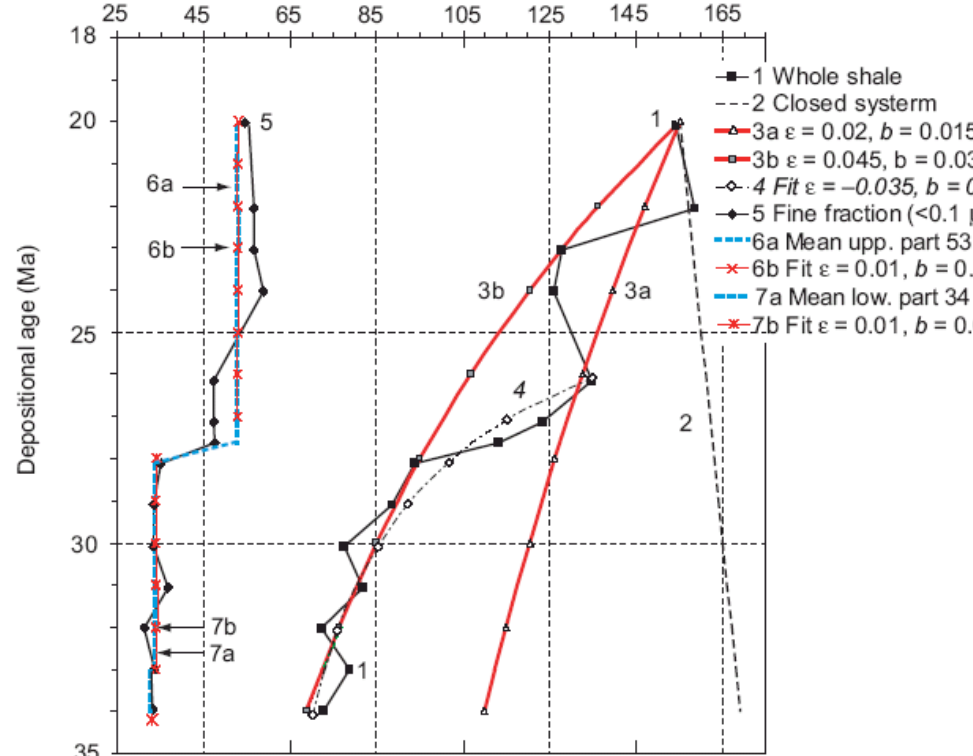
Figure 8. The K-Ar apparent ages of the coarse- (line 1) and fine-grained size fractions (line 5) of the Gulf Coast sequence [37]. For the coarse-grained fraction: calculated K-Ar dates if the particles were a closed system (line 2); data points approximately bracketed by the two-process model of 40 Ar escape ( ε Ma − 1 ) and K addition (b Ma − 1 ) at different rates. The abrupt change in the decline of the K-Ar date at the depositional age of about 26 Ma in the sediment is simulated (curve 4) by addition of K at a fast rate of b = 0.15 Ma − 1 without 40 Ar escape ( ε = 0). For the fine-grained fraction: data points between 20 Ma and 27 Ma approximated by a constant K-Ar apparent age of 53 Ma (line 6a); the data point between 28 Ma and 34 Ma, constant apparent age of 34 Ma (line 7a). The latter two straight-line segments approximated by the model of 40 Ar release and K addition at relatively low rates (curves 6b and 7b). See Equation (A4b) in the Appendix A.